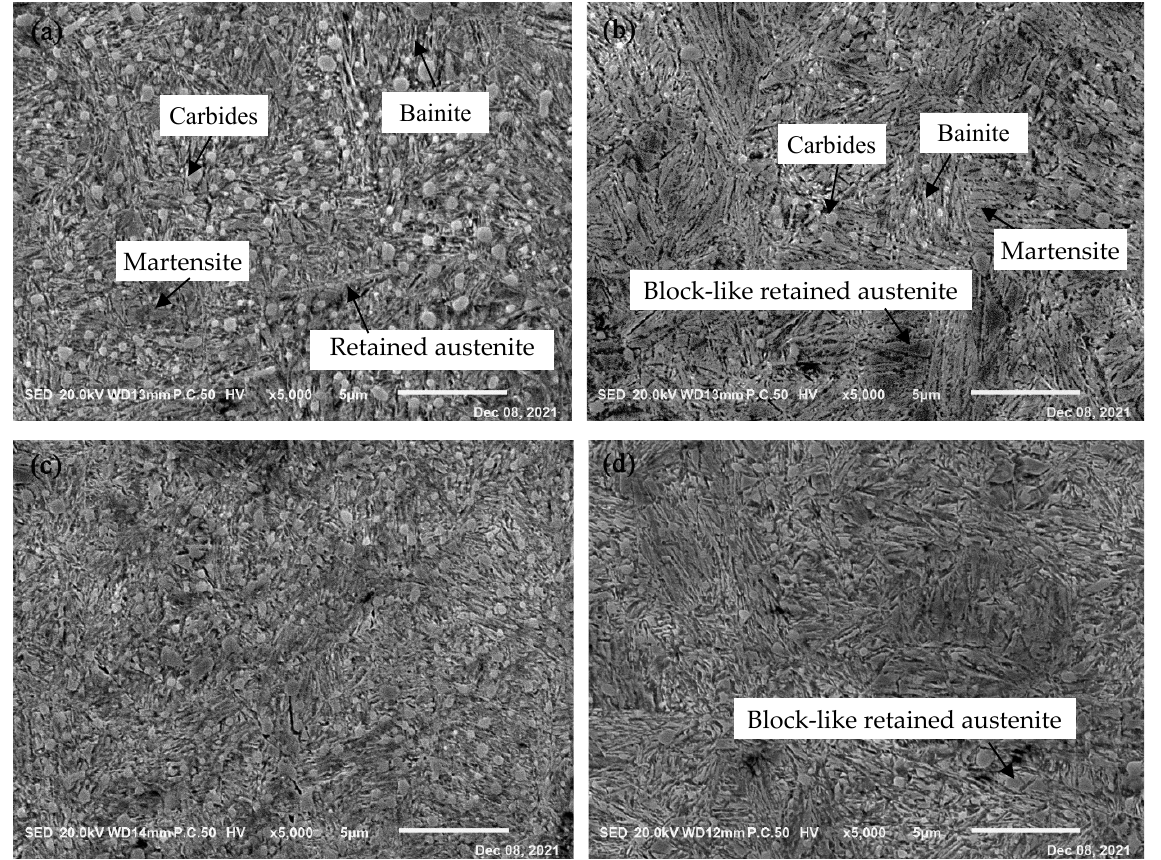
Figure 4. SEM micrographs of the steels austempered at different temperatures for 8 h: ( a ) GCr15SiMo at 210 °C; ( b ) GCr15Si1Mo at 210 °C; ( c ) GCr15SiMo at 230 °C; ( d ) GCr15Si1Mo at 230 °C.